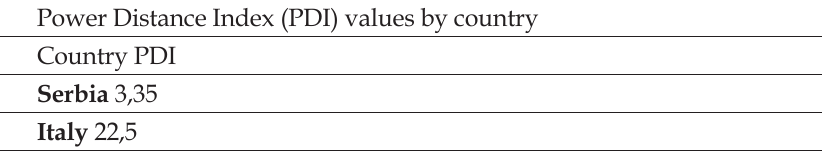
Table 2. Power Distance Index (PDI) values by country.